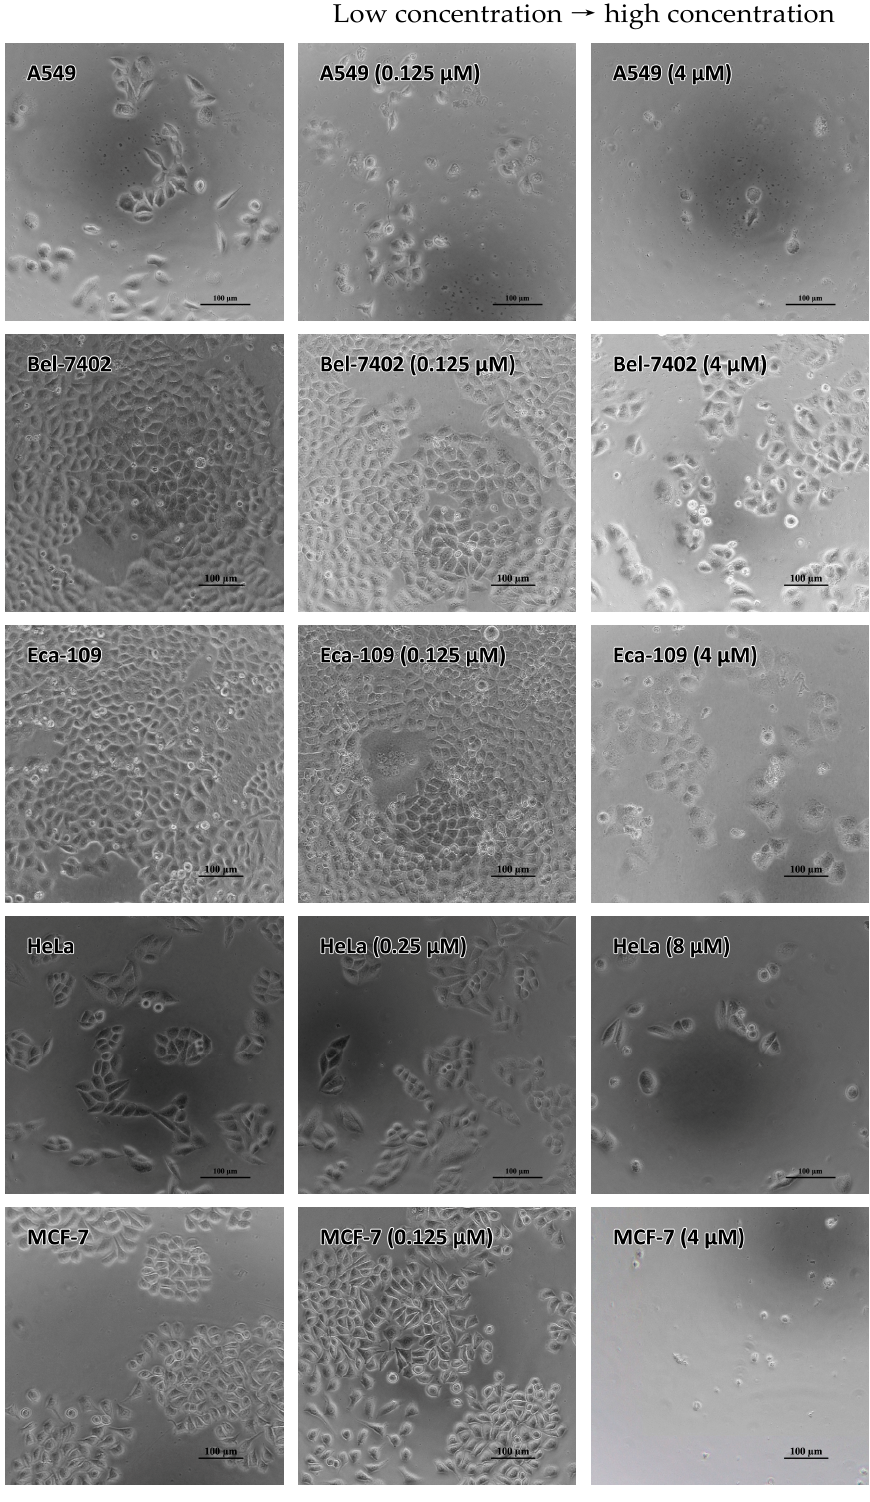
Figure 3. Microscopic photographs of the A-549, Bel-7402, Eca-109, HeLa and MCF-7 cancer cells treated with increasing concentrations of compound 1a .